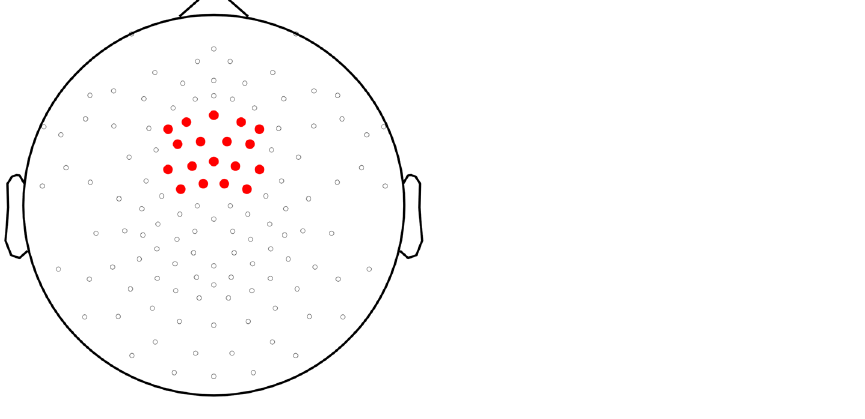
Figure 2. Location of 128 electrodes in the HCGSN. The highlighted electrodes were used for